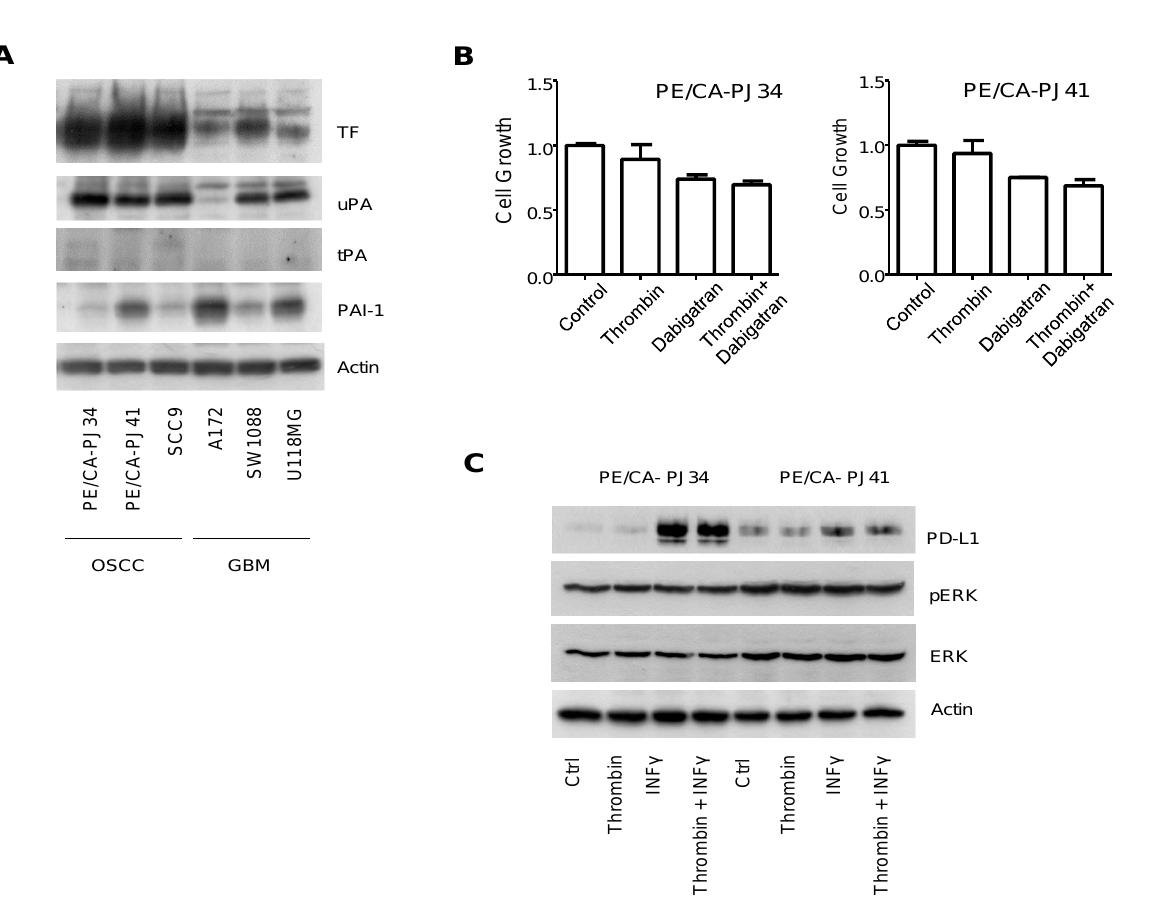
Figure 10. Immunoblot analysis of the coagulome in OSCC and the lack of a direct effect of thrombin on the growth of OSCC cells. ( A ) Immunoblot analysis of the expression of the Tissue Factor ( F3 ), uPA ( PLAU ), tPA ( PLAT ) and PAI-1 ( SERPINE1 ) in OSCC cell lines (PE/CA-PJ34, PE/CA-PJ41, SCC9) compared to GBM cell lines (A172, SW1088, U118MG). Actin was provided as a control.